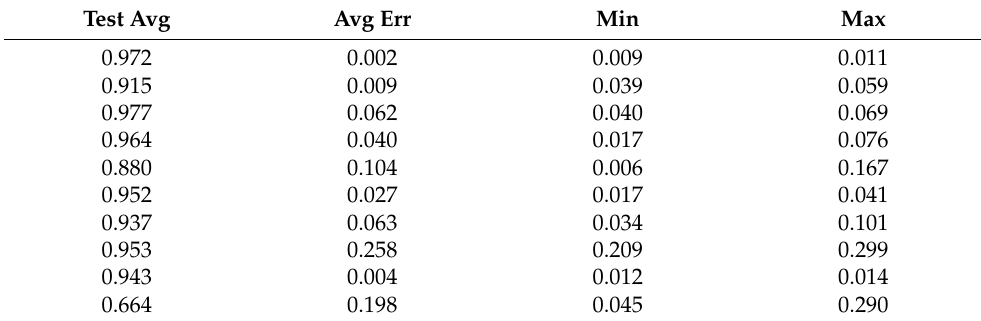
Table A176. Set 3, trials 11–20 data (single 0.5 PR value).